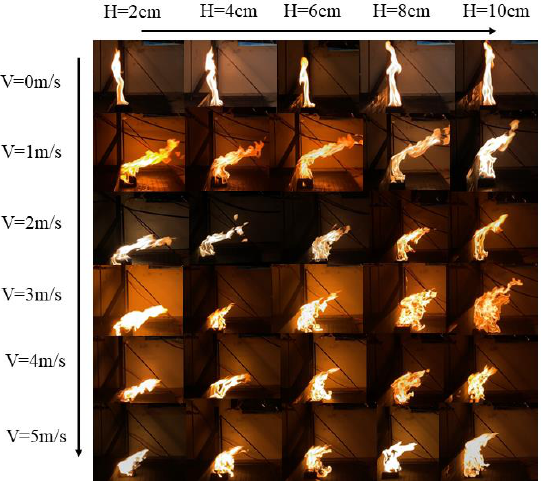
Figure 3. Pool fire flame shape under a stable combustion stage at a 0 – 5 m/s crosswind velocity.